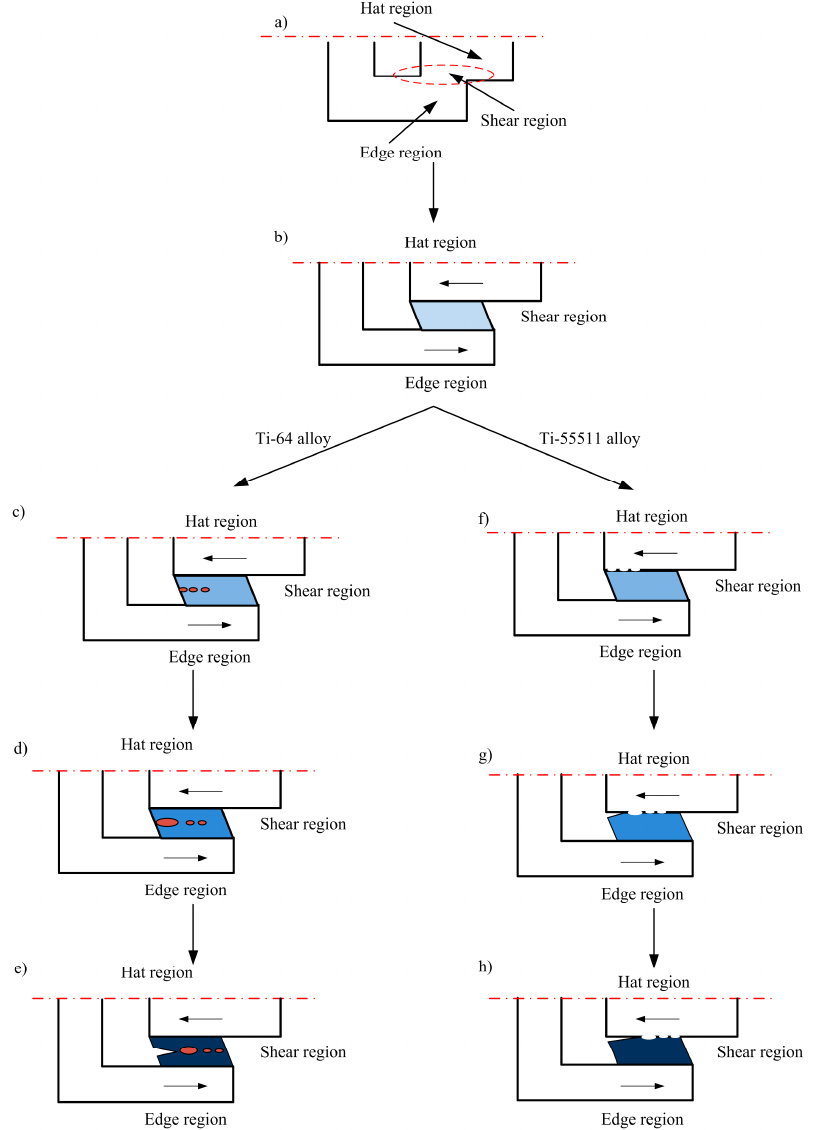
Figure 14. Schematic diagram showing the mechanisms of dynamic failure for two investigated materials. ( a ) undeformed sample; ( b ) ASB formation; ( c ) voids occurred; ( d ) adjoining voids coalesce; ( e ) crack formed and propagated within ASB; ( f ) microcracks formation (white points at the shear band/matrix interface); ( g ) adjoining microcracks coalesce; and ( h ) crack propagated within ASB.